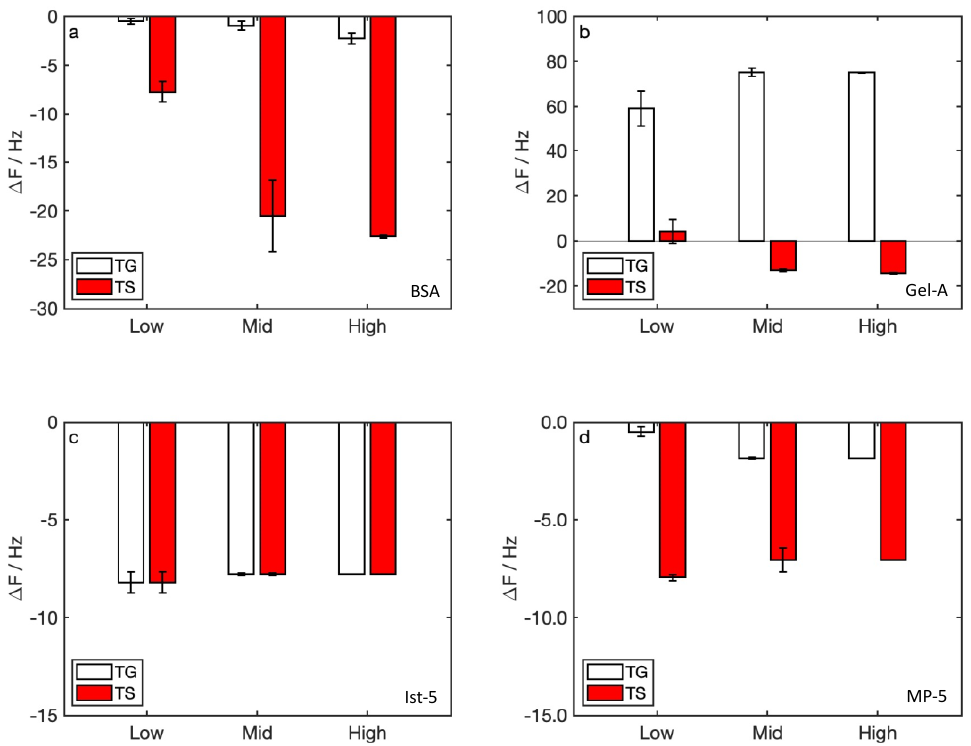
Figure 4. Detection of polyphenols in watery solutions: Δ f vs. sample concentration (see Table 1) in ( a ) BSA, ( b ) Gel-A, ( c ) Ist-5, ( d ) MP-5. Focusing on TG-based samples, the Δ f plotted against tannin concentration (Figure 5a,b) and sample pH (Figure 5c,d), showed that data might follow a linear trend in all cases. The same behavior was not verified for TS-based samples (data not shown).